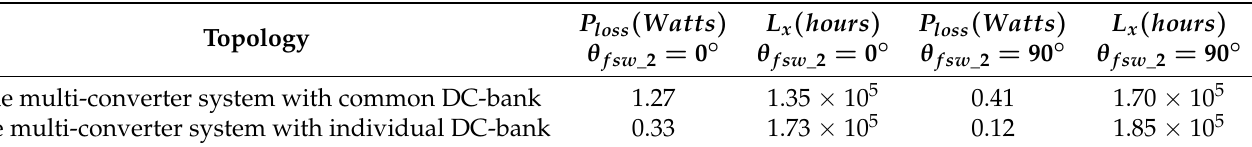
Table 7. Power-loss, and life-expectancy of the DC-link capacitor calculated using the experimental results.